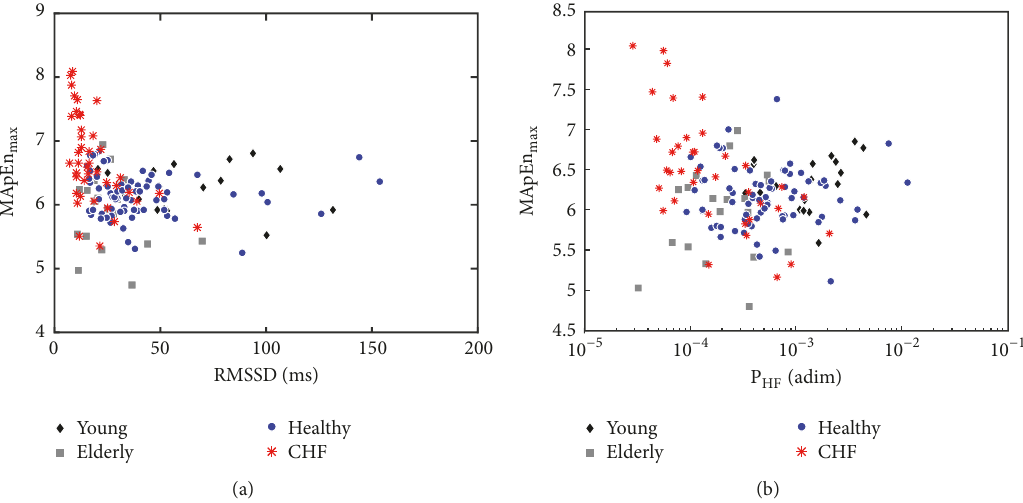
Figure 10: Frequency-domain indices: (a) P subjects during the night period. ∗ indicates statistically significant differences by Mann-Whitney U test ( p -values < 0.05) between groups.